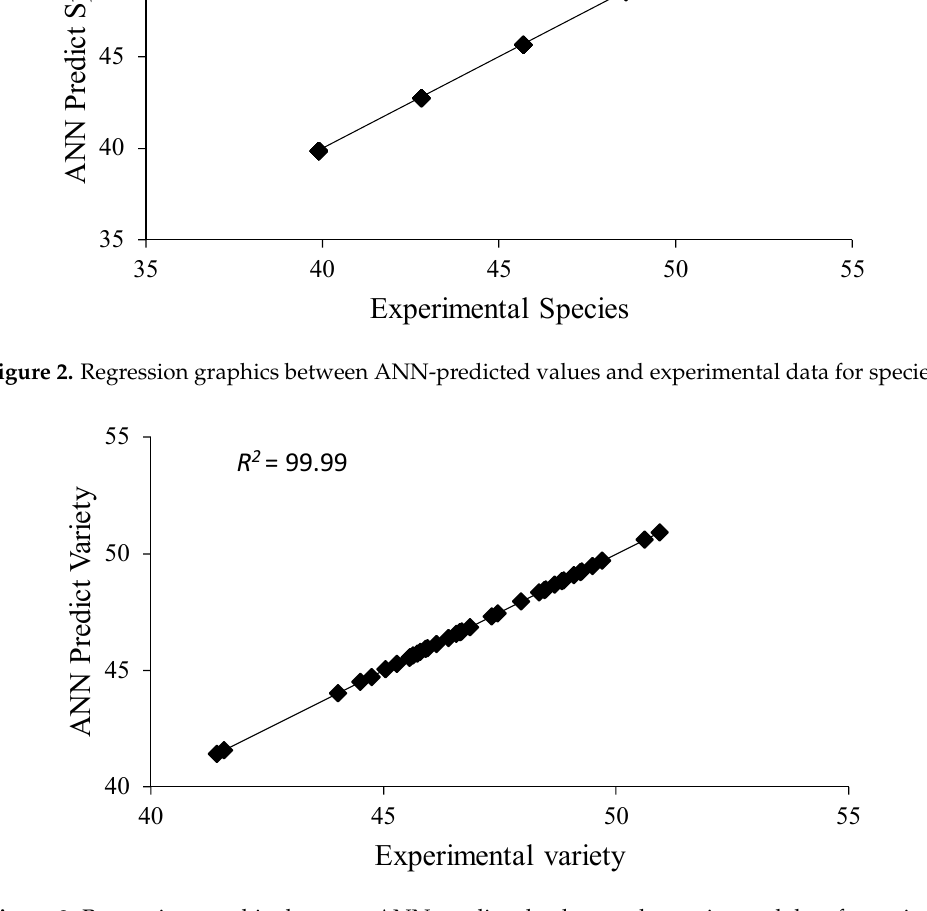
Figure 3. Regression graphics between ANN-predicted values and experimental data for variety. them are given in Table 8. The mean error value for variety was found to be 0.009% and 0.001% for